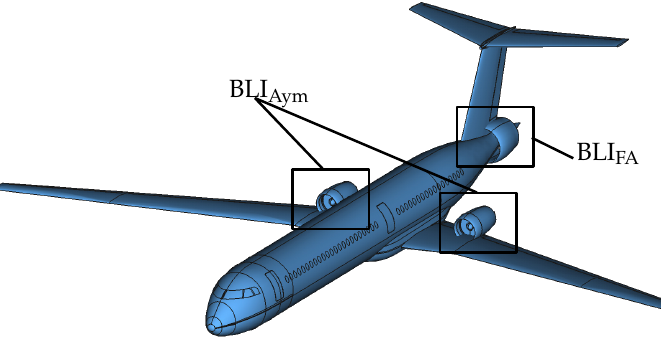
Figure 3. V2 SE 2 A mid-range aircraft with asymmetric and full annular BLI [11]. While the latter ones are subject to a circumferentially asymmetric inlet distortion (as illustrated in Figure 4a; blue color represents areas of low momentum fluid), the tail engine ingests boundary layer fluid over the full annulus (FA, Figure 4b). This neglects the effect of